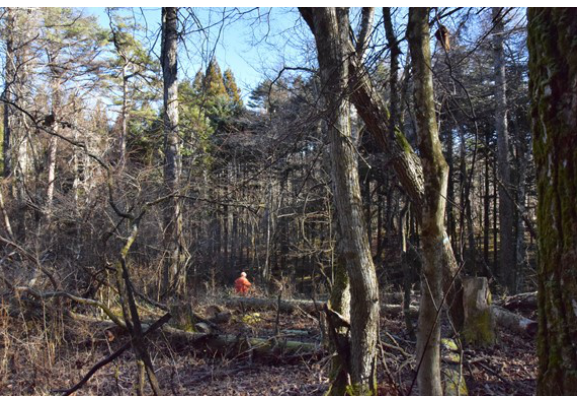
Figure 10 . A shooter who stationed in the